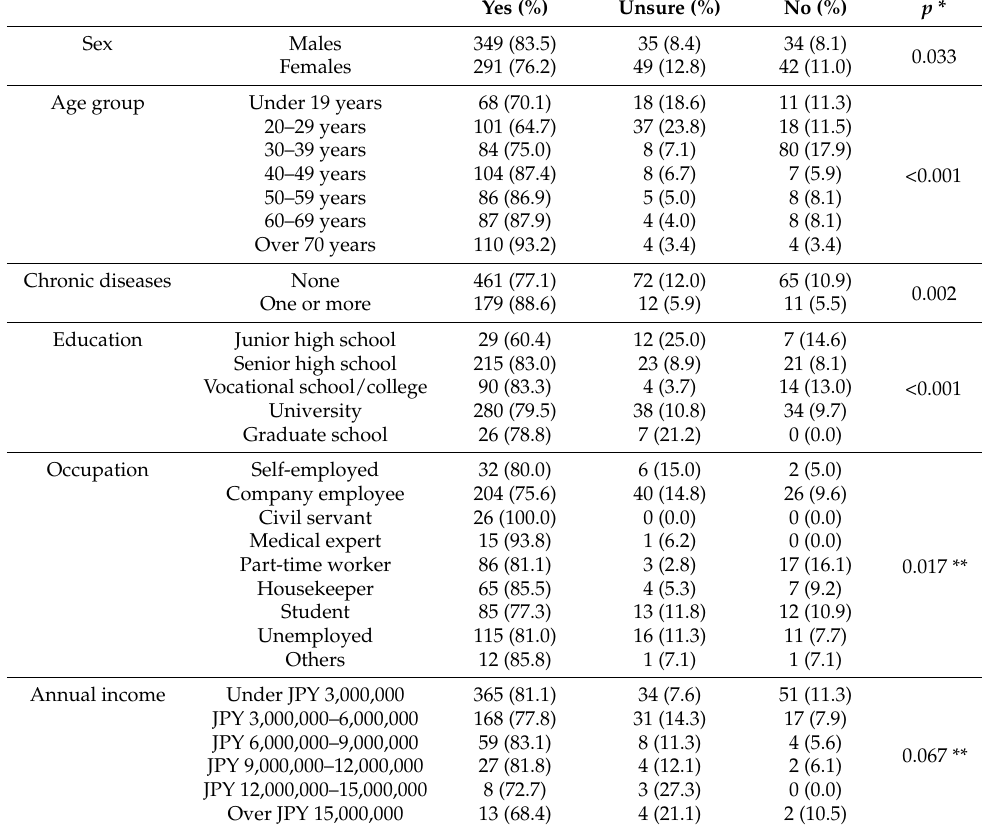
Table 2. Willingness to be vaccinated against COVID-19 by